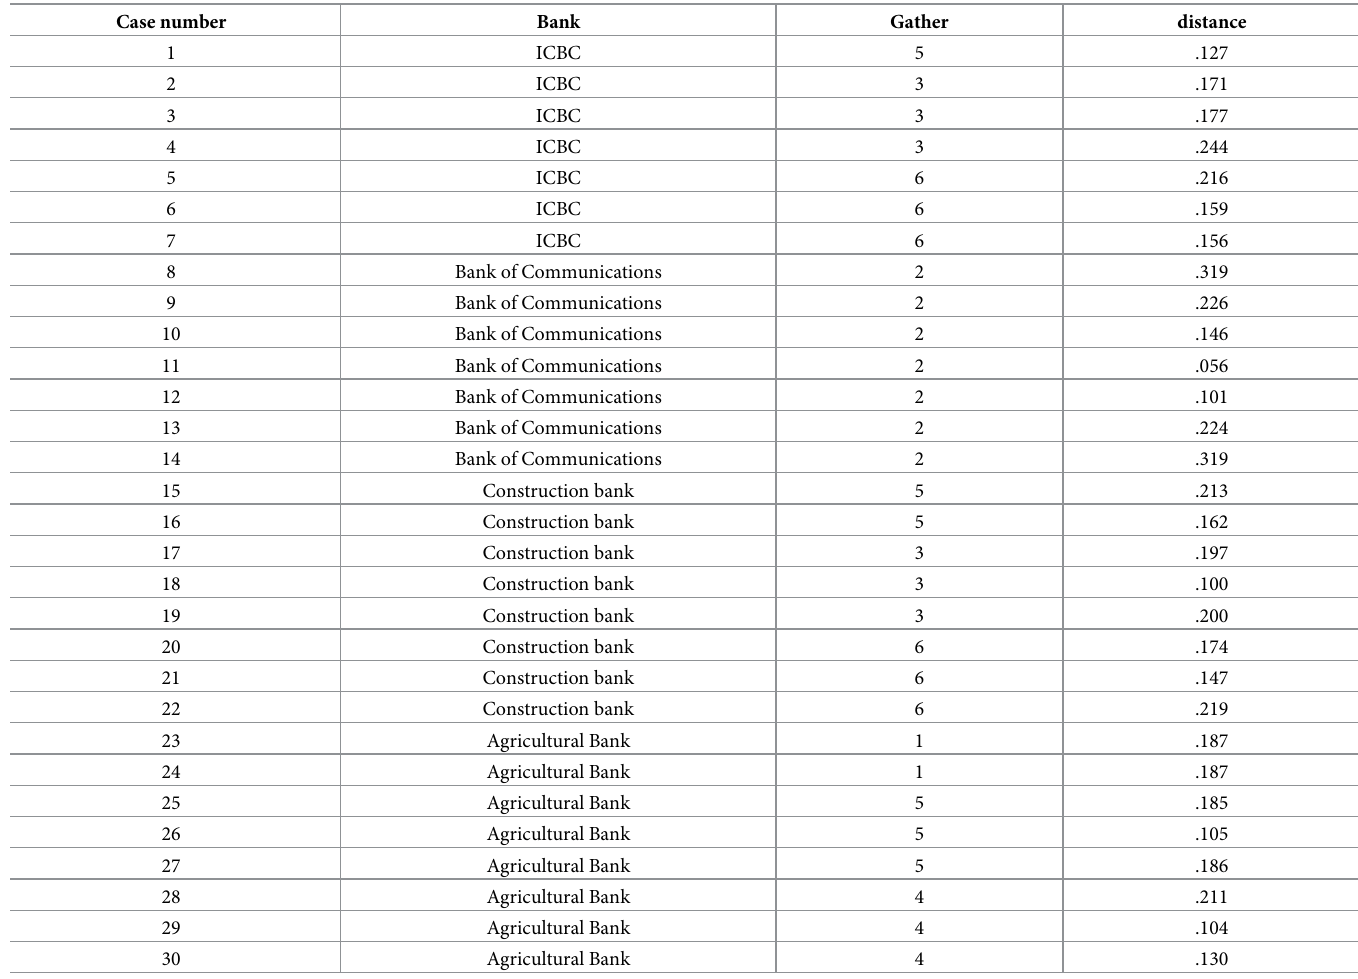
Table 4. Group members